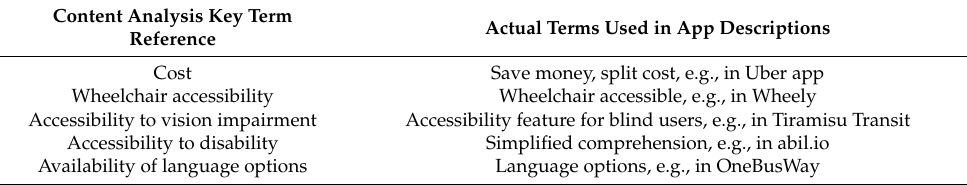
Table 2. Content analysis key terms and actual terms used in app